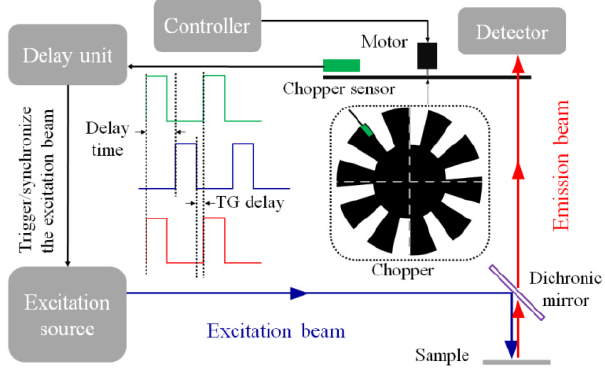
Fig. 2. TG implementation of